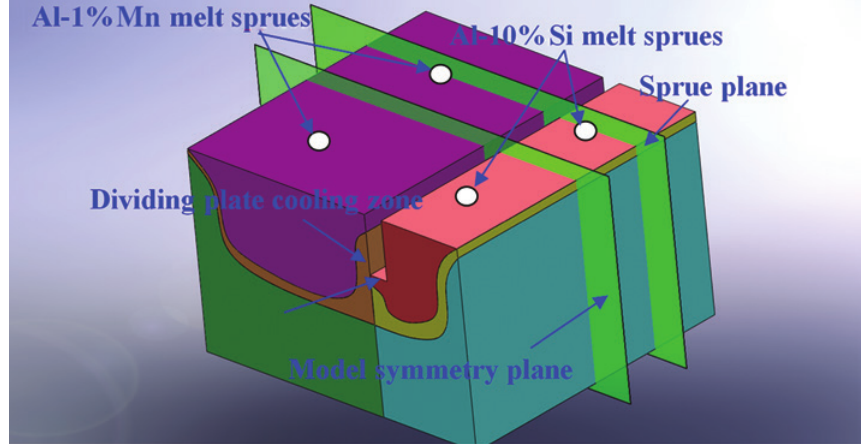
Figure 2: Diagram of model symmetry plane and sprue plane.